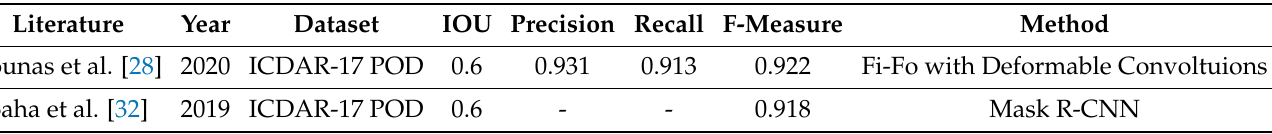
Table 4. Figure detection performance comparison.